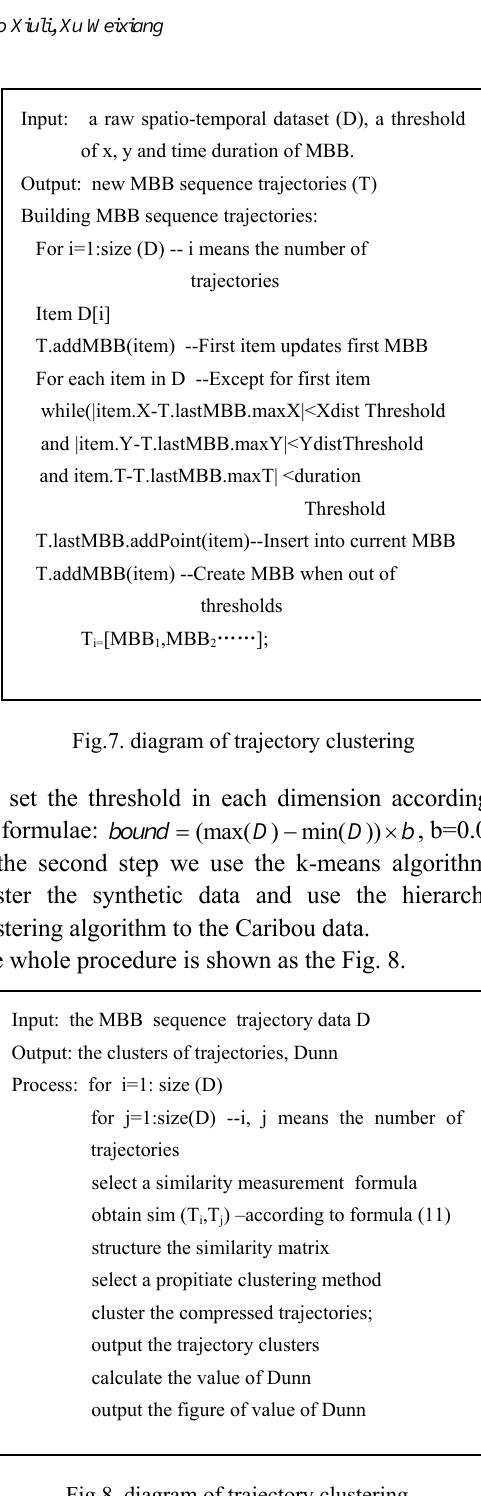
Fig.8. diagram of trajectory clustering